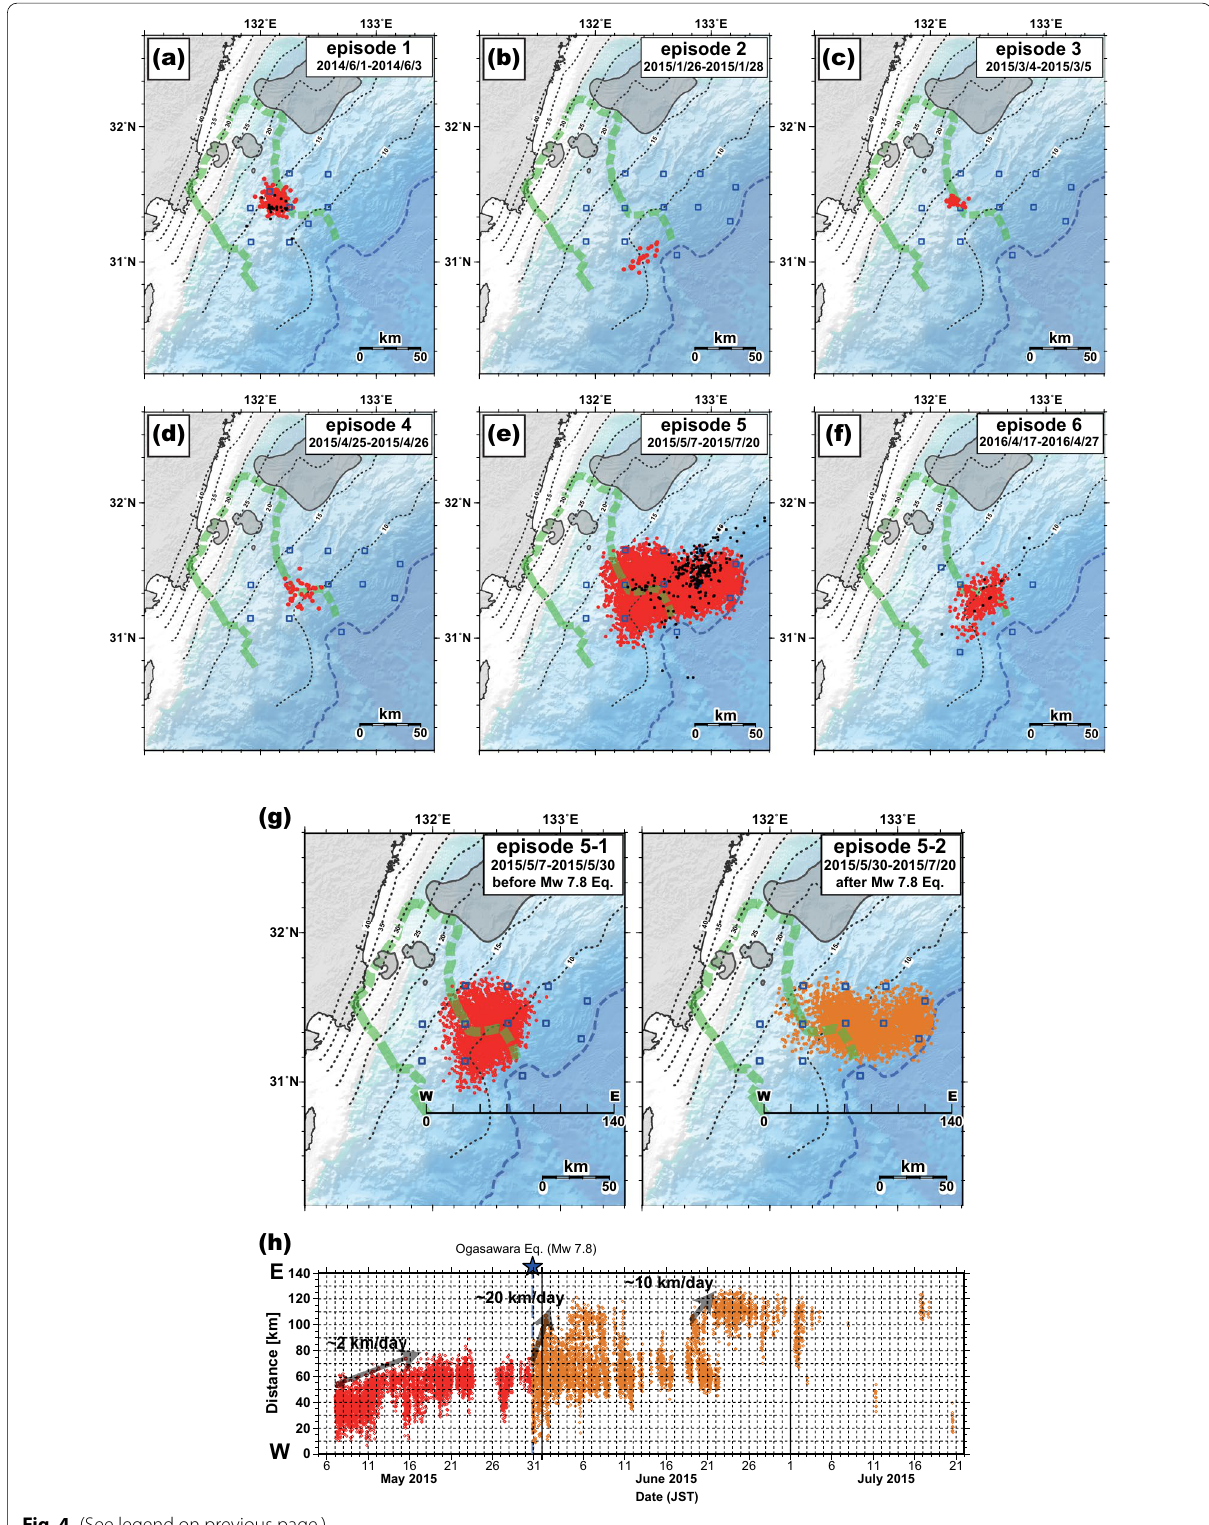
Fig. 4 (See legend on previous